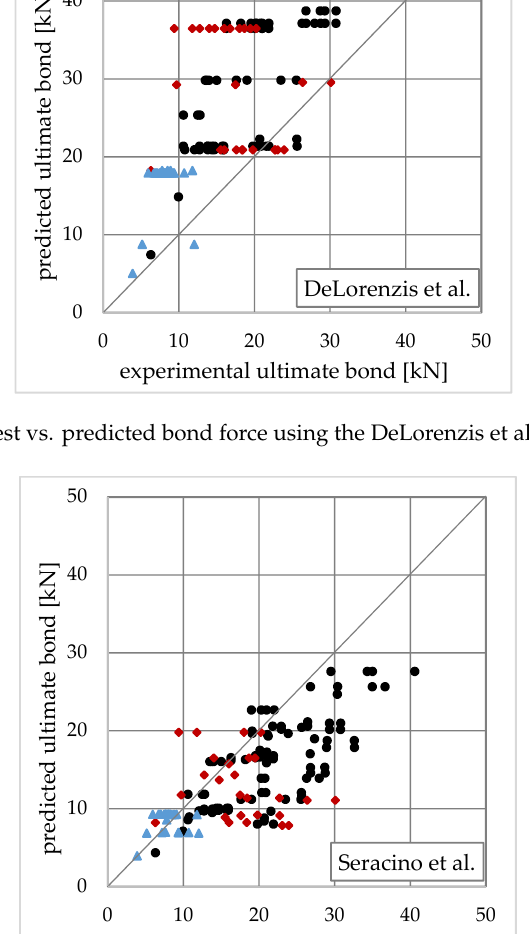
Figure 18. Test vs. predicted bond force using the Seracino et al. model [30].